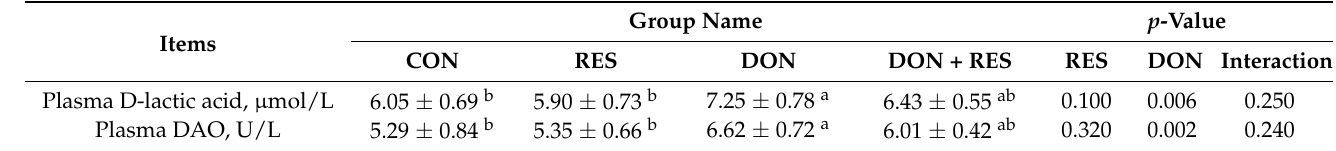
Table 6. The effects of RES on the jejunal permeability of piglets.